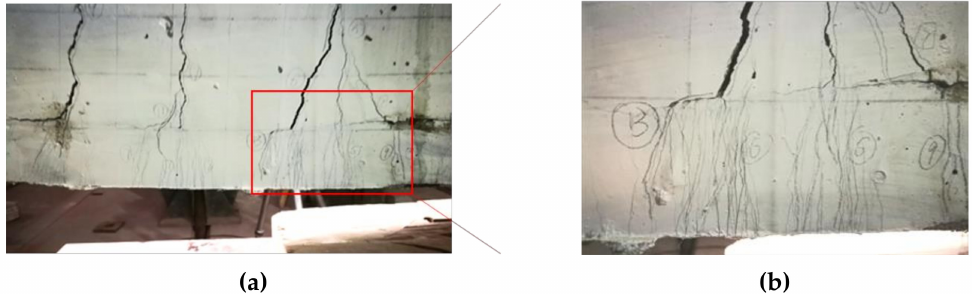
Figure 10. Failure of SSC-UHDCC beams (side B surface): ( a ) SSC-UHDCC-6; and ( b )